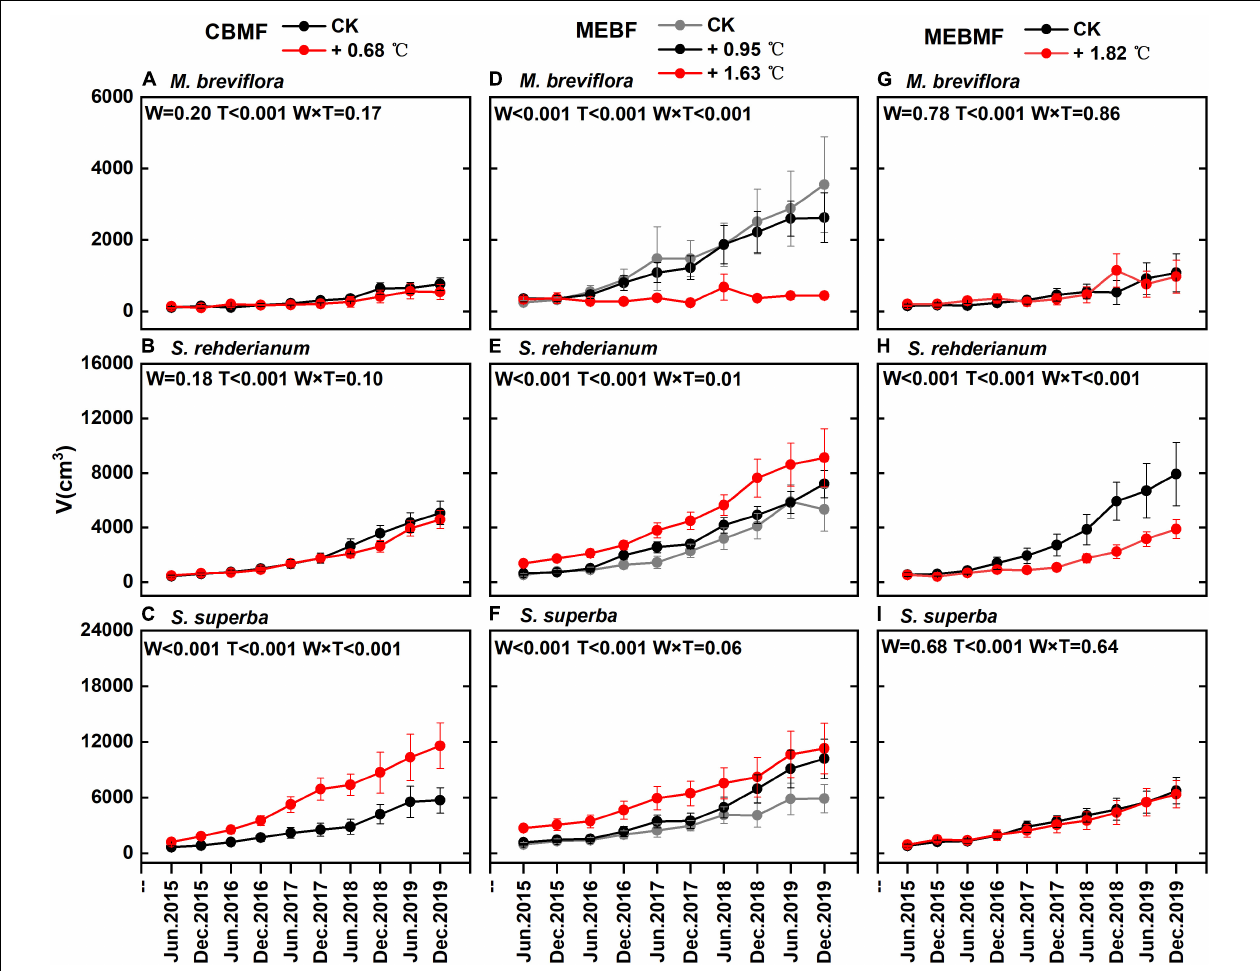
FIGURE 6 | (A,D,G) The stem volume (V, cm 3 ) of Machilas breviflora in coniferous and broadleaf mixed forest (CBMF), mountain evergreen broadleaf forest (MEBF) and monsoon evergreen broadleaf forest (MEBMF), from June 2015 to December 2019; (B,E,H) V of Syzygium rehderianum in CBMF, MEBF and MEBMF; (C,F,I) V of Schima superba in CBMF, MEBF and